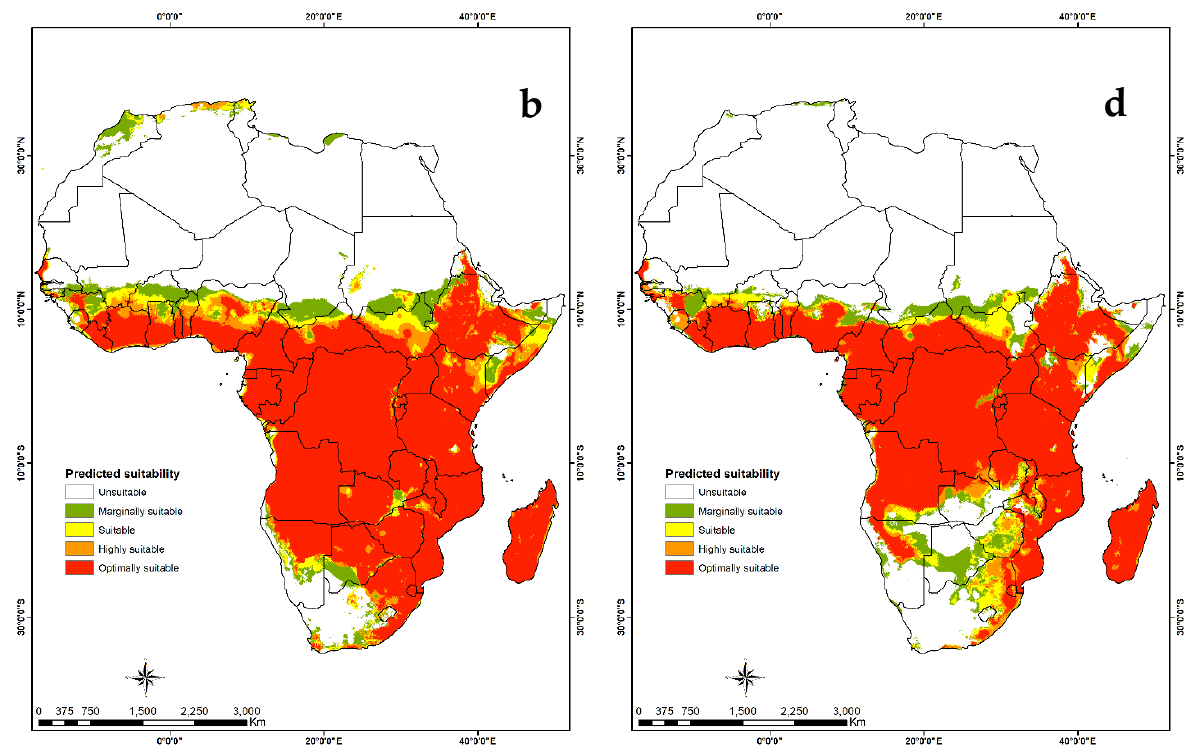
Figure 6. Predictive suitability map of the geographic distribution of Bunaea alcinoe . ( a ) Suitability map generated by the MaxEnt algorithm under current climate scenario; ( b ) suitability map generated by the GARP algorithm under current climatic scenario; ( c ) suitability map generated by MaxEnt algorithm under future climatic scenarios and ( d ) suitability map generated by the GARP algorithm under future climatic scenarios.